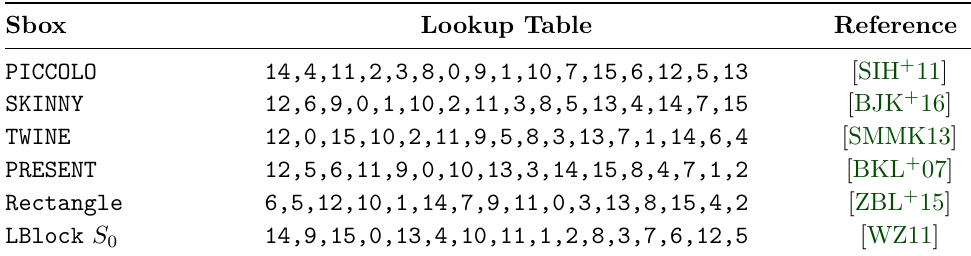
Table 7: Sboxes used for